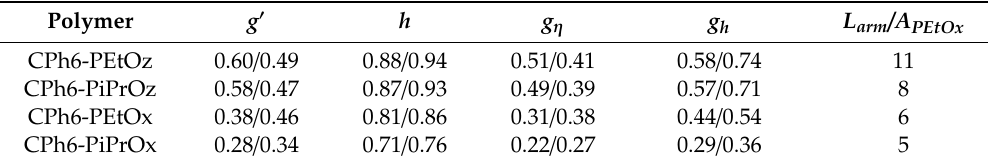
Table 4. Contraction factors for investigated polymer